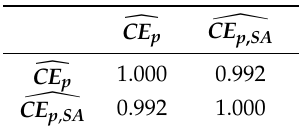
Table 7. Correlation between predicted carbon emissions price and predicted carbon emissions price (SA).